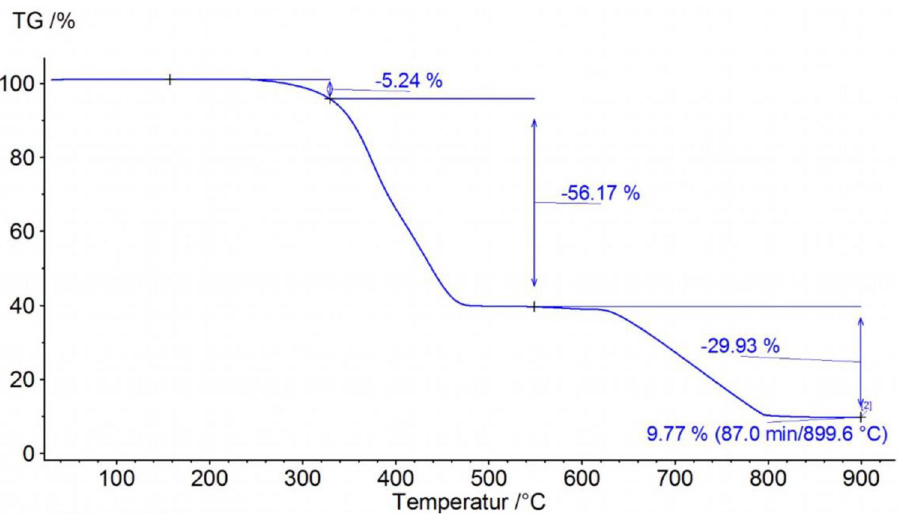
Figure 2. Thermogravimetric analysis of rubber